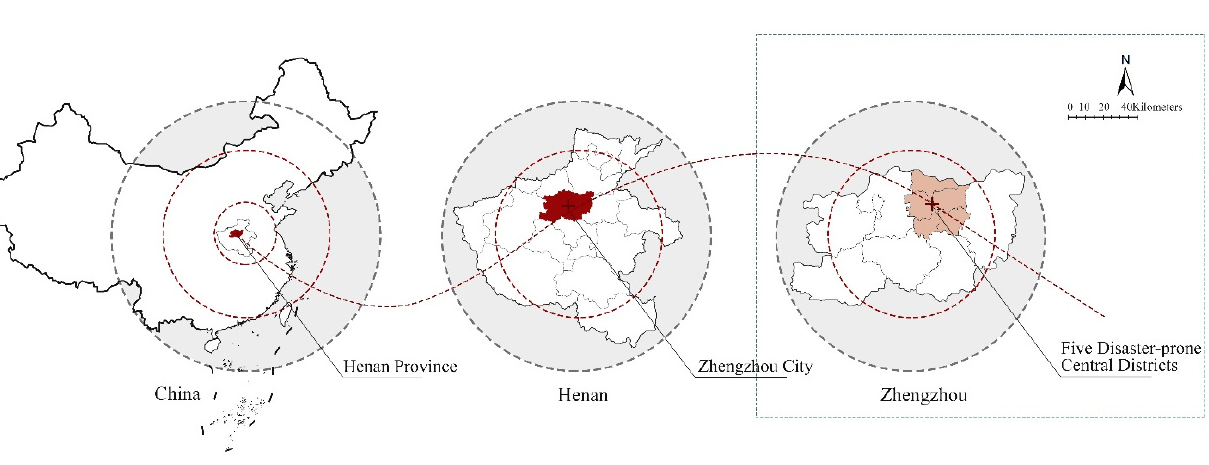
Figure 2. Precipitation from 0:00 ‒ 23:00 on 20 July 2021, in each administrative region of Zhengzhou City. 2.2. Collection and Processing of VGI Data and Indicators The rainstorm began on 17 July and became severe on 20 July, trapping many people on this day. VGI used in this study was obtained from data compiled by volunteers from 20 ‒ 23 July 2021. Volunteers collected information from social media platforms such as Sina Weibo [52], and WeChat for providing mutual aid during the disaster. They used an online sharing document tool called Shimo (https://shimo.im/ (accessed on 8 February 2022)), sorting the various information into one open-access document accessible to